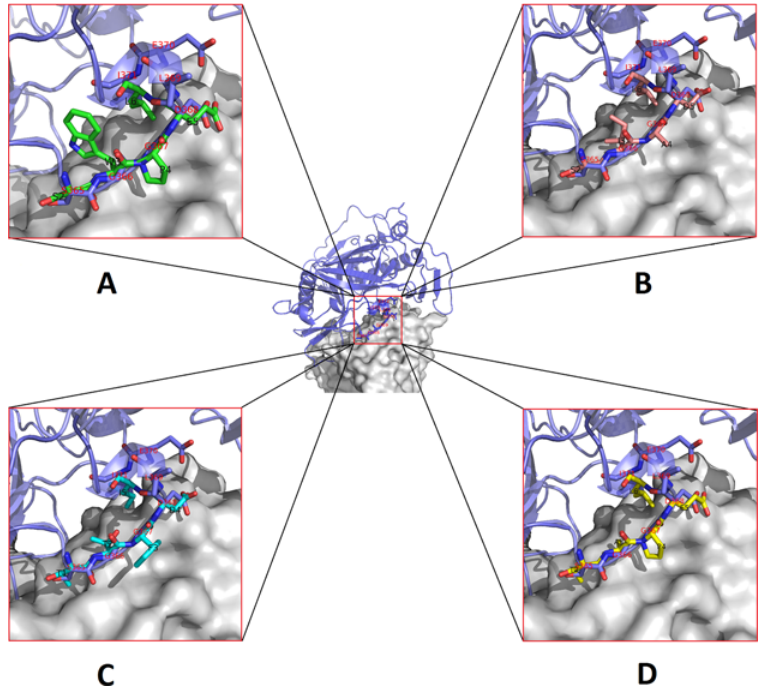
Fig 5. Models of interaction between fragments of the peptides which were able to rescue viral infectivity and VRC01-gp120 complex. Antibody showed as a surface (gray color), secondary structure of gp120 is colored in blue, amino acid residues of SGGDLEI gp120 region is labeled with red, fragments of peptides E1 (SWPEL), E2 (TAPEL), E10 (TTFDI) and E11 (SIADL) are shown as a colored sticks (A, B, C and D,